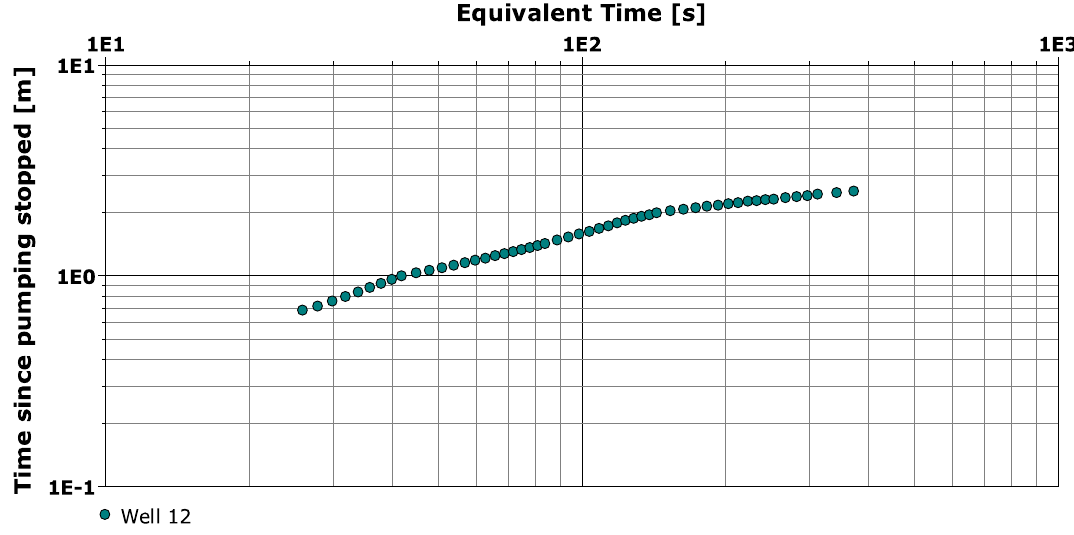
Fig.17 Plotting of recovery rate of well-12 using aquifer mapping software